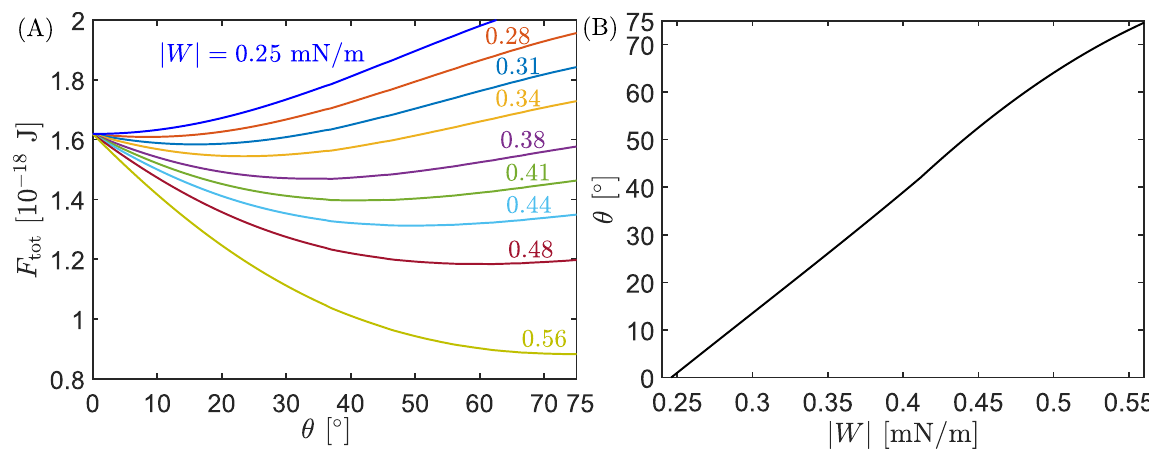
Fig 3. Energy landscape for dome-shaped assemblies. (A) Total energy of the system as a function of the attachment angle θ , for different values of the membrane–protein adhesion strength | W |. For | W | = | W | as ’ 0.25 mN/m, the energy landscape has a minimum at θ = 0˚. As | W | increases beyond this value, the attachment angle θ of the minimum energy state (i.e. the optimal attachment angle) moves continuously towards higher θ -values, reaching θ = 75˚ (corresponding to neck closure and scission) for | W | = | W | sc ’ 0.56 mN/m. (B) Optimal attachment angle θ as a function of | W |. In both (A) and (B), the total area of the bud is A 42